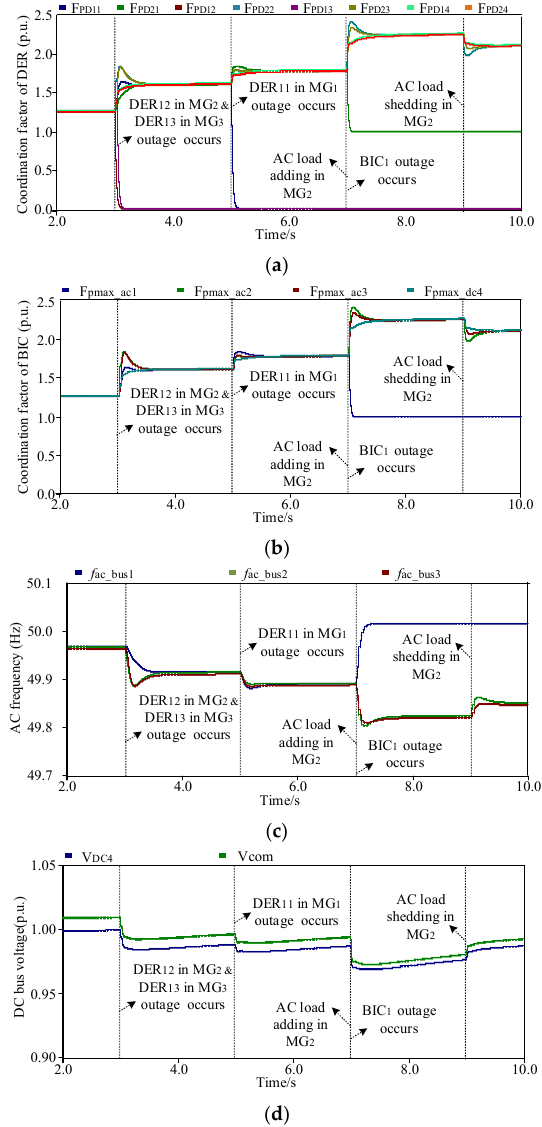
Figure 15 . Performance of proposed method under DER and BIC outages: ( a ) Output power of AC/DC DERs, ( b ) Output power of BICs, ( c ) Frequencies of AC MGs, ( d ) Voltages of common bus and DC MG.